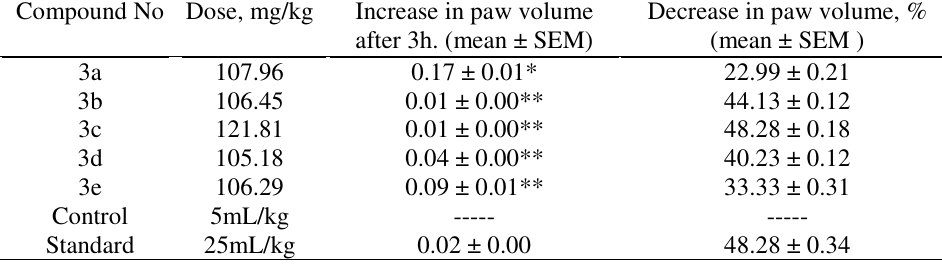
Table 2. Anti-inflammatory activity of compounds (3